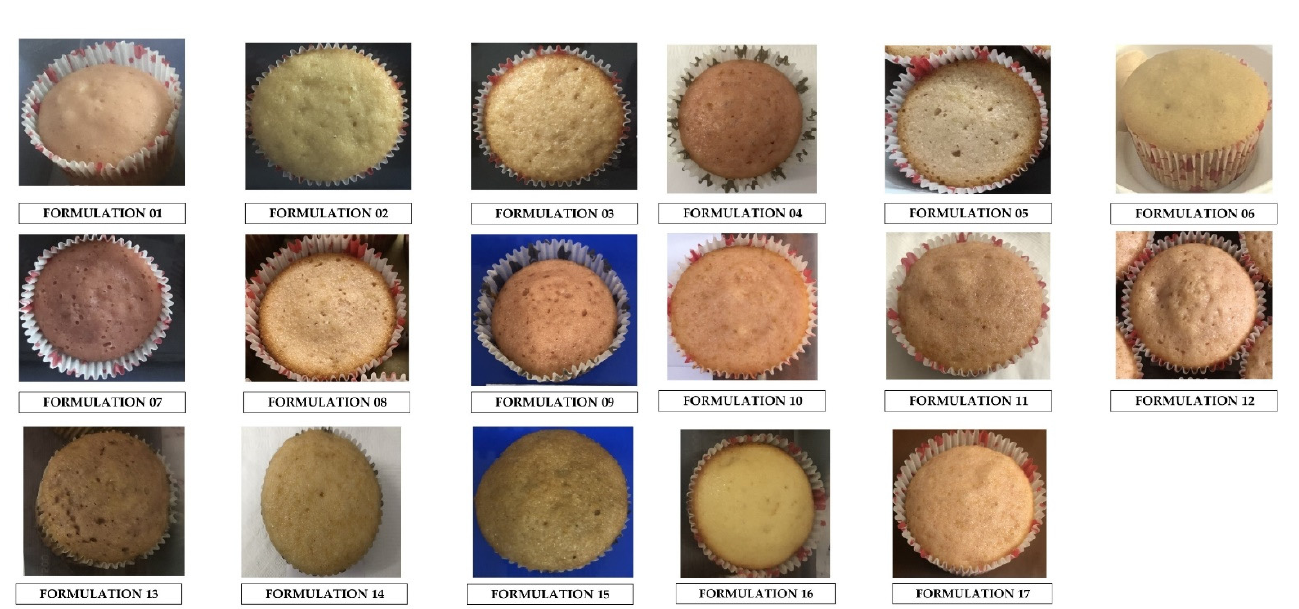
Figure 1. Images of Roselle muffin obtained with different formulations combinations. This quadratic relationship was observed between the sensory responses and the Following up on these observations, analysis of variance (ANOVA) was performed extract volume, citric acid, and sodium bicarbonate. (Table 2). The quadratic model, with an R 2 value of 0.70 for texture and 0.94 for OAA, was suggested.